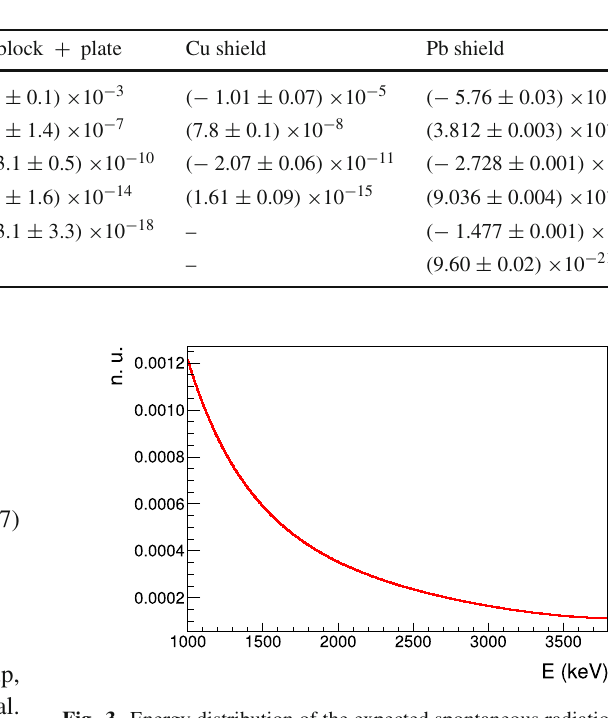
Fig. 3 Energy distribution of the expected spontaneous radiation sig- nal, resulting from the sum of the emission rates of all the components of the setup, weighted with the efficiency functions. The area of the distribution is normalised to unity (n.u.) in the energy range Δ E